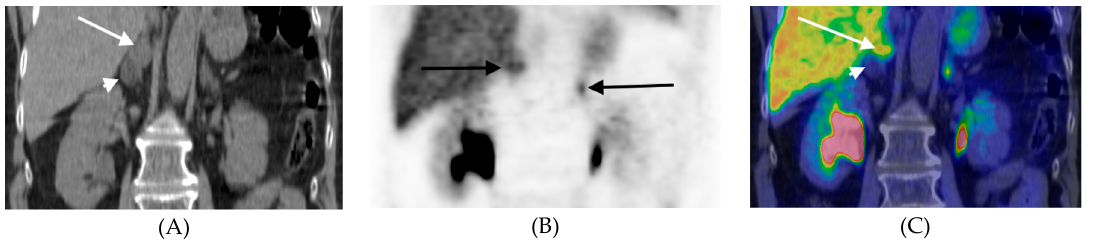
Figure 3. 11 C-HED-PET/CT, coronal mages, of patient #2 (Table 3) with a collision tumor in the right adrenal showing a cranial component with high tracer uptake comprising a PCC (arrows) and a caudal tumor portion representing an adrenocortical adenoma (arrow head). The normal contralateral adrenal is indicated with an arrow in the PET image. ( A ) CT, ( B ) PET, ( C ) PET/CT fusion.